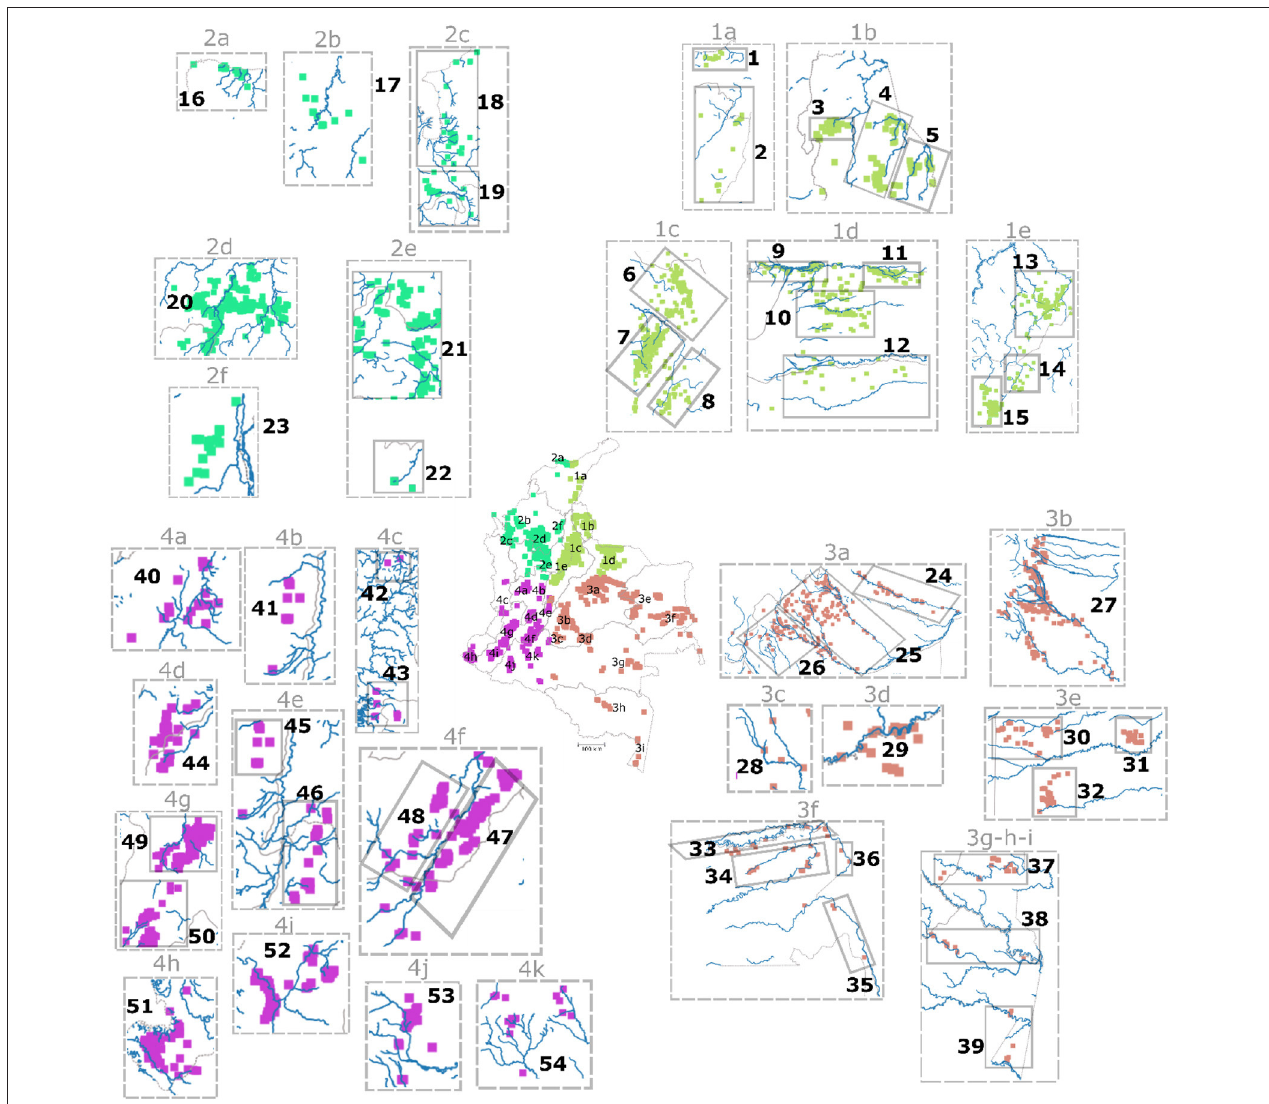
FIGURE 3 | Map of regions/sub-regions (middle map) of cultivated cacao in Colombia, and a close view of the 54 provinces with corresponding rivers (panels numbered 1–54).